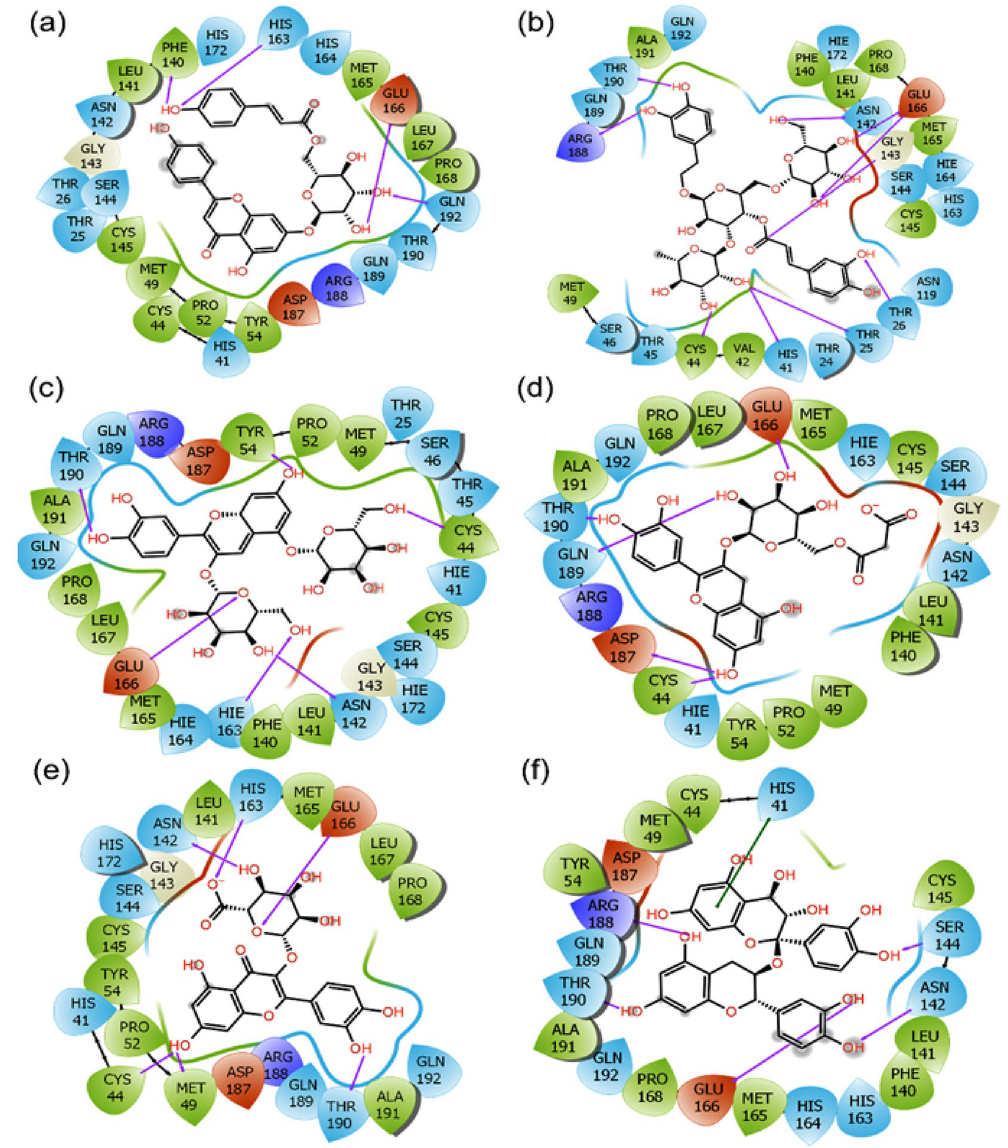
Figure 5. 2D molecular contact profiling for the re-docked poses of SARS-CoV-2 M pro with selected phytochemicals from selected plants, viz. ( a ) SARS-CoV-2 M pro -Echinacin, ( b ) SARS-CoV-2 M pro -Echinacoside, ( c ) SARS-CoV-2 M pro -Cyanin, ( d ) SARS-CoV-2 M pro -Cyanidin 3-(6 ʺ -alonylglucoside), ( e ) SARS-CoV-2 Mpro- Quercetin-3-O-glucuronide, and ( f ) SARS-CoV-2 M pro -Proanthocyanidins. These poses exhibited hydrogen bond (pink arrows), π–π (green lines), hydrophobic 55 , polar (blue), negative (red), positive (violet), and glycine (grey) intermolecular interactions for the respective docked